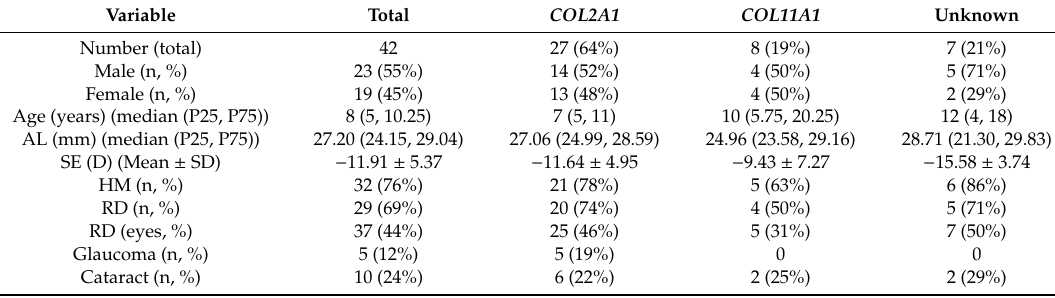
Table 1. Demographic and clinical data for this